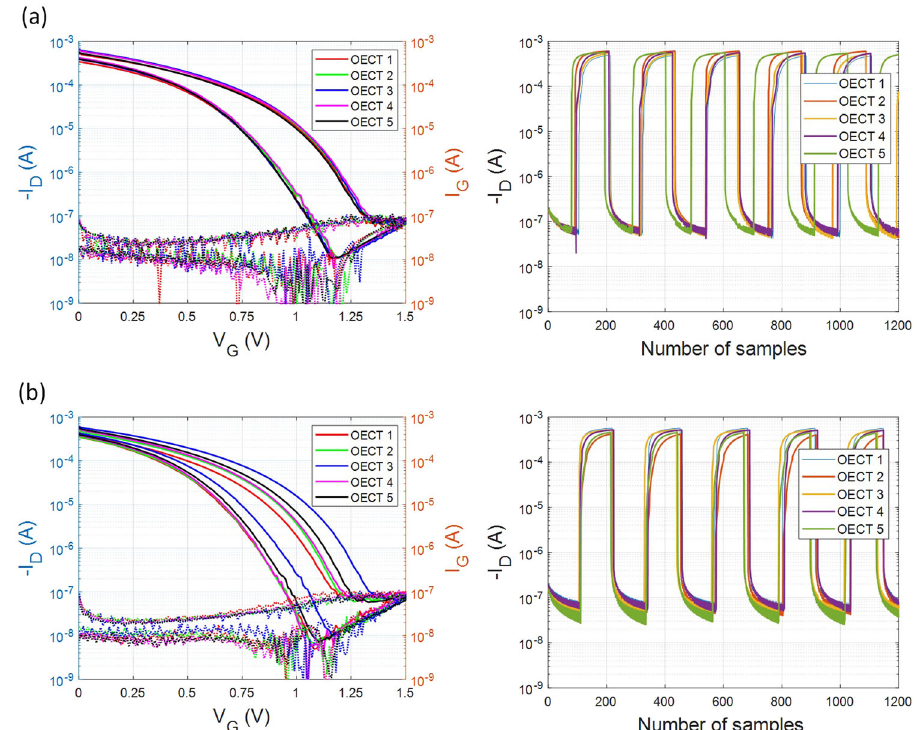
Fig. 6 Dynamic switching behavior of two blocks of Small OECTs along with their transfer measurements. a Dynamic switching of a Small OECT block with matching transfer curves, b dynamic switching of a Small OECT block with varying transfer curves. Despite the variations in transfer characteristics, the ON/OFF current ratios that are obtained are identical (both showing I D,ON and I D,OFF of ~400 µA and ~30 nA, respectively), which is an important result from a circuit design